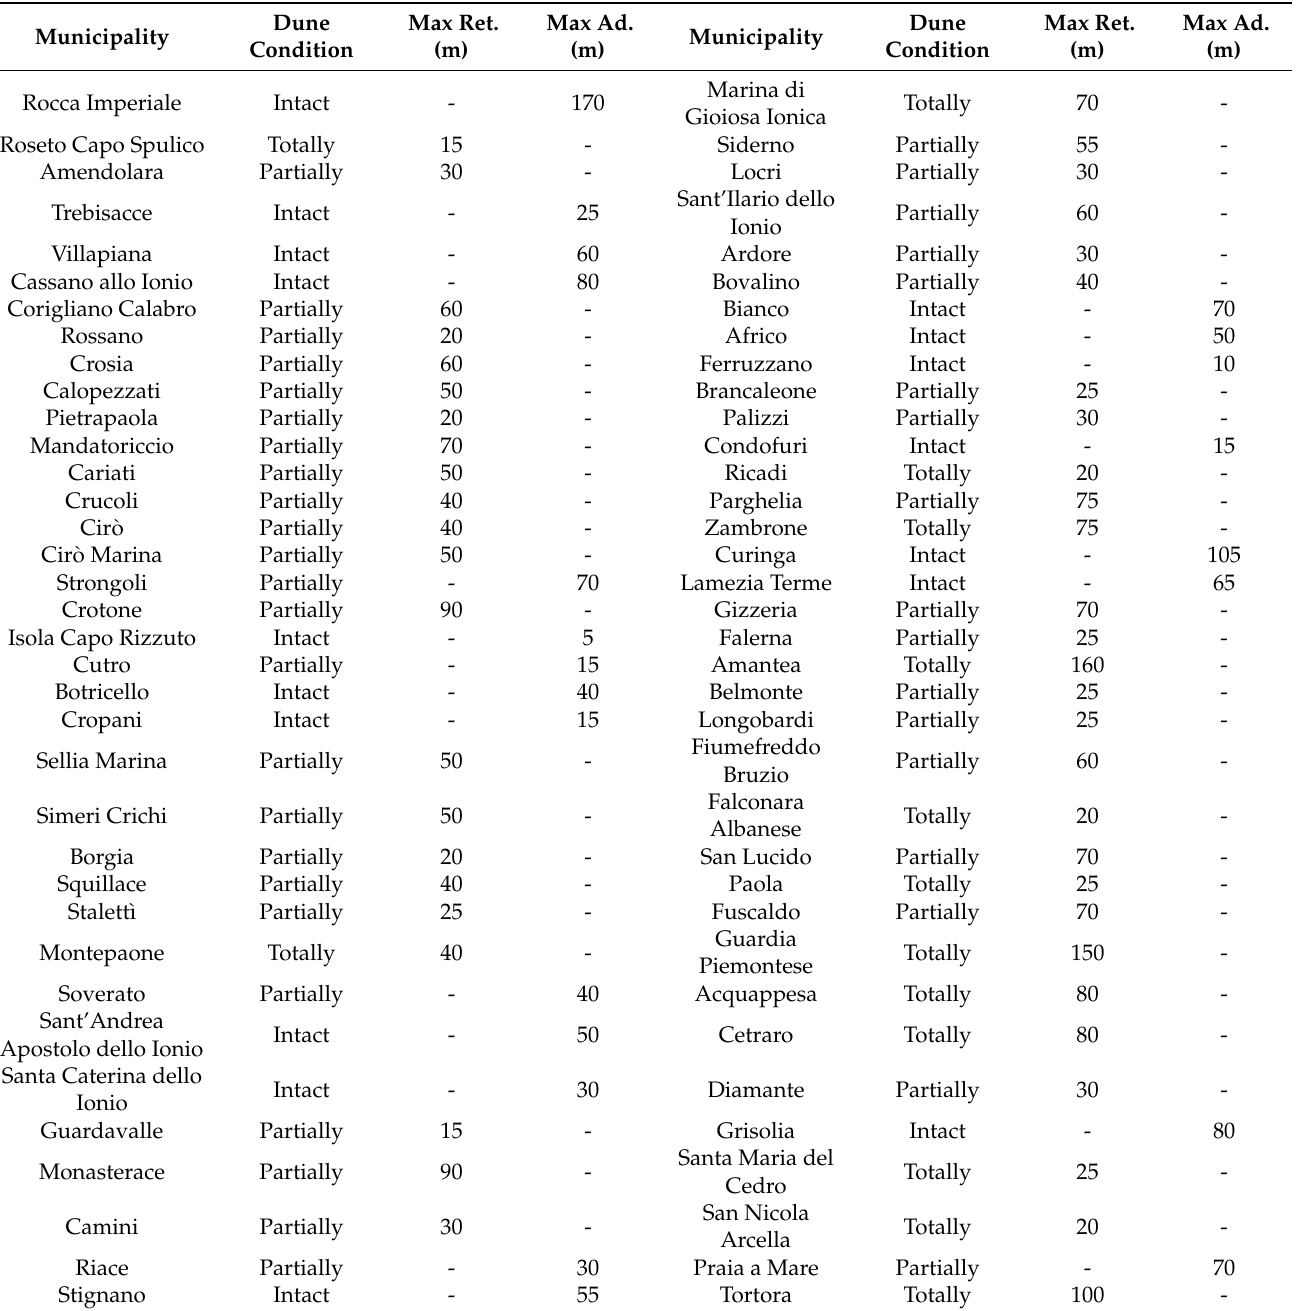
Table 1. Summary of the dune system condition (intact, partially, or totally destroyed by anthro- pogenic causes) and of the maximum shoreline retreat of advancement values for each of the 72 ana- lyzed municipality (ordered clockwise from the Ionian coast to the Tyrrhenian coast). Legend: Max Ret. = maximum retreat; Max Ad. = maximum